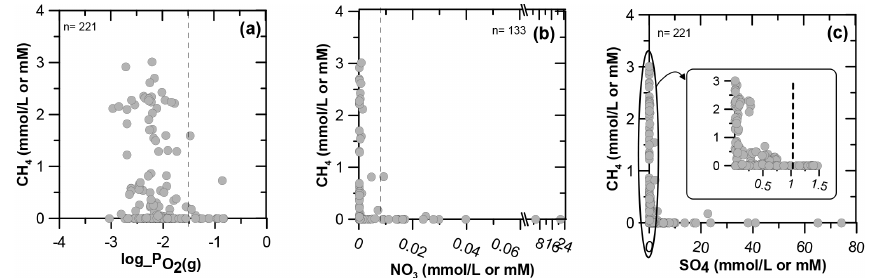
Figure 6. Redox diagram and binary relationship between methane–nitrate and sulfate concentration in the GOWN water samples.